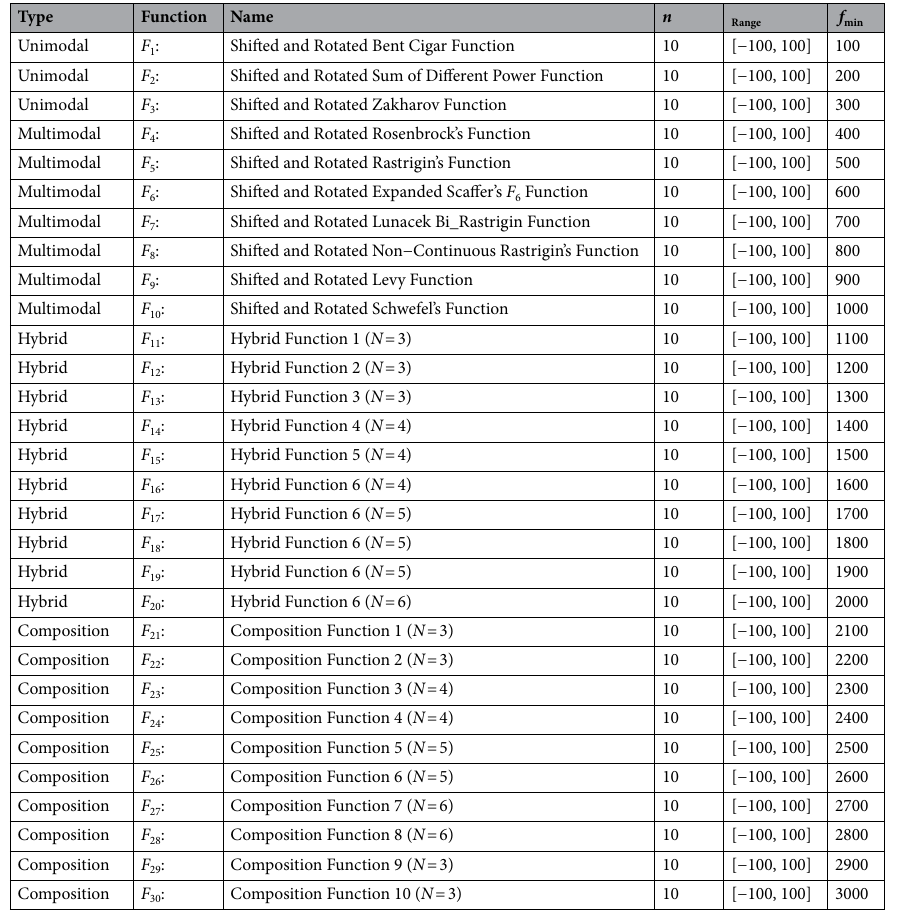
Table 6. The definition of CEC2017 test